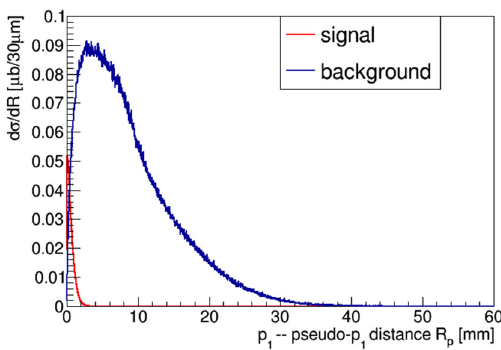
Fig. 8 The distribution of the probability that the distance, R p , between the p 1 proton and pseudo- p 1 positions in the ALFA detec- tor (see text). The red line the signal event sample, the blue line the background